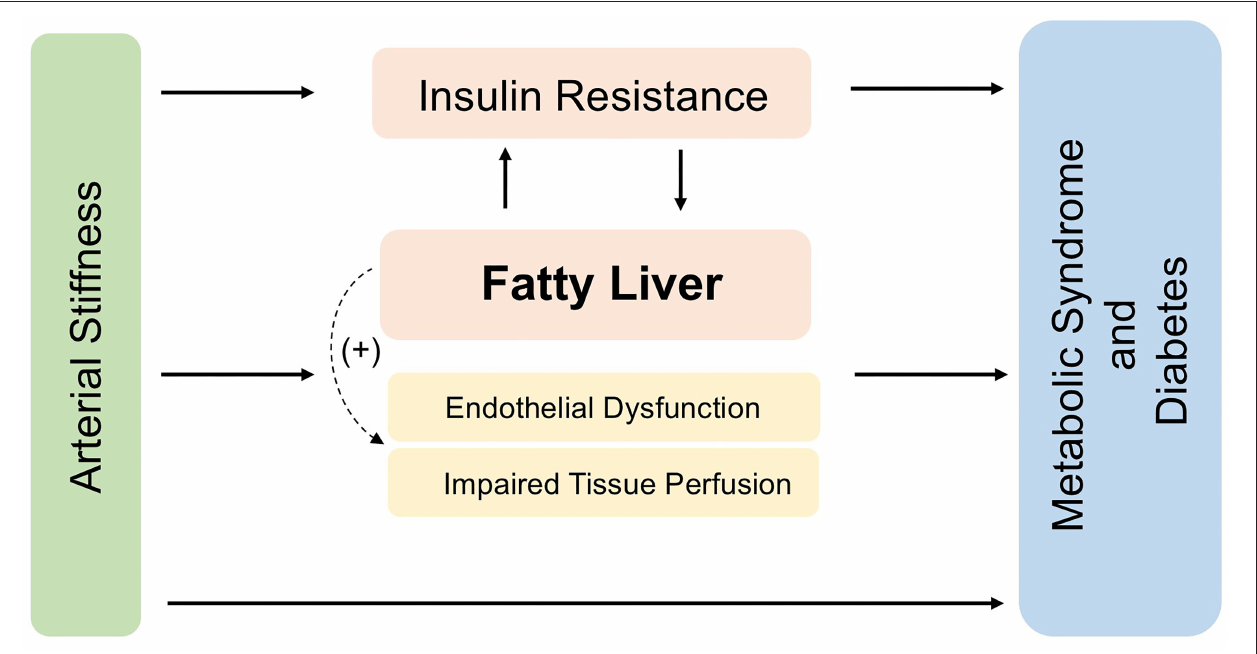
FIGURE 3 | Diagram hypothesized for mediation, characterizing the relationship between arterial stiffness and metabolic